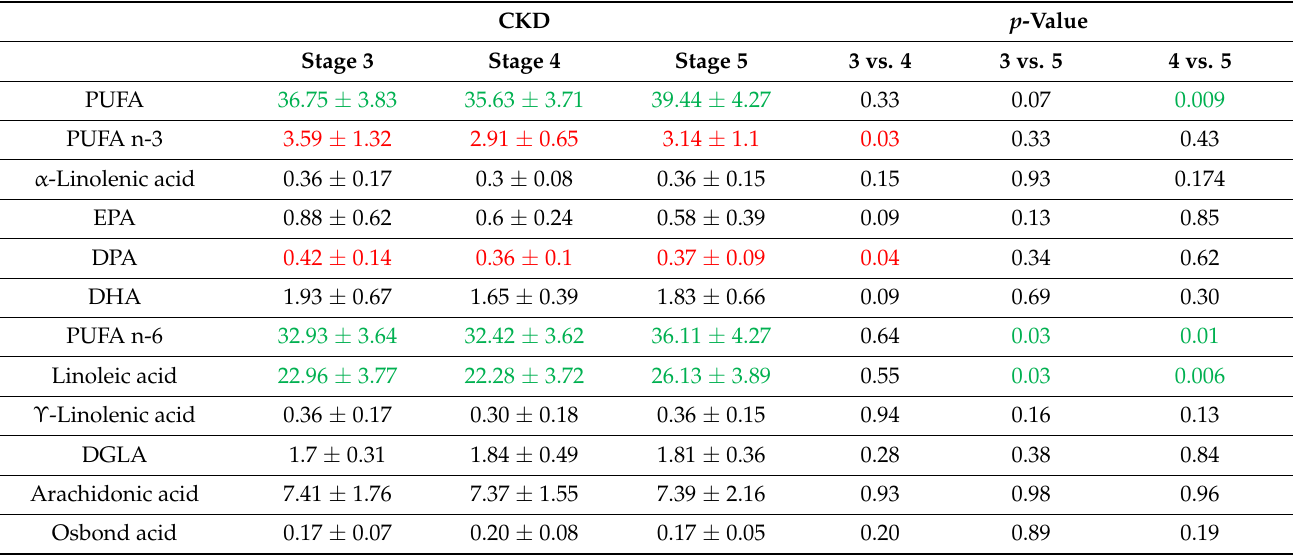
Table 2. PUFA profile among CKD stages.